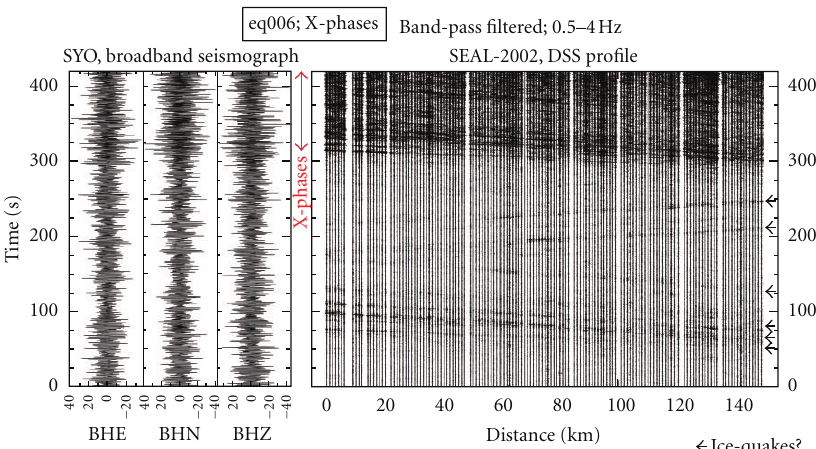
Figure 15: Band-pass filtered (0.5–4.0 Hz) waveforms of the record section for X-phases together with local events (ice-quakes) (event#; eq006). (left) Three-component broadband seismograms at SYO (right) SEAL-2002 recordings. The unknown originated X-phases are evidently identified at the time-window after 300 s. Several local (ice-related?) events are recorded as the former phases, which are raveled as “ice-quakes?”.